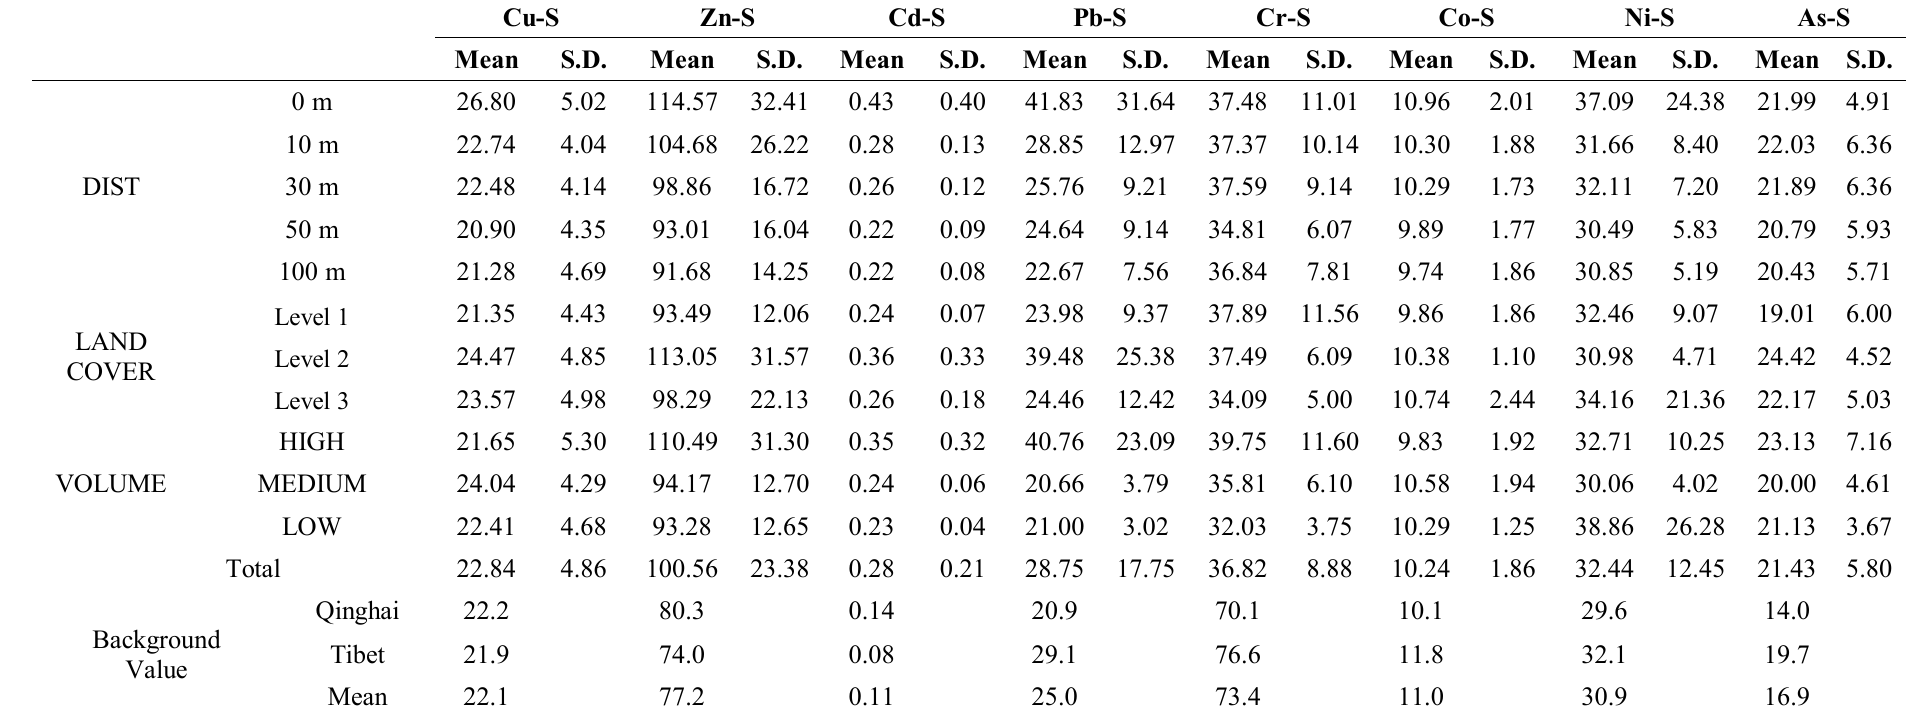
Table 4. Descriptive Statistics of Trace Element Concentrations in Roadside Soil